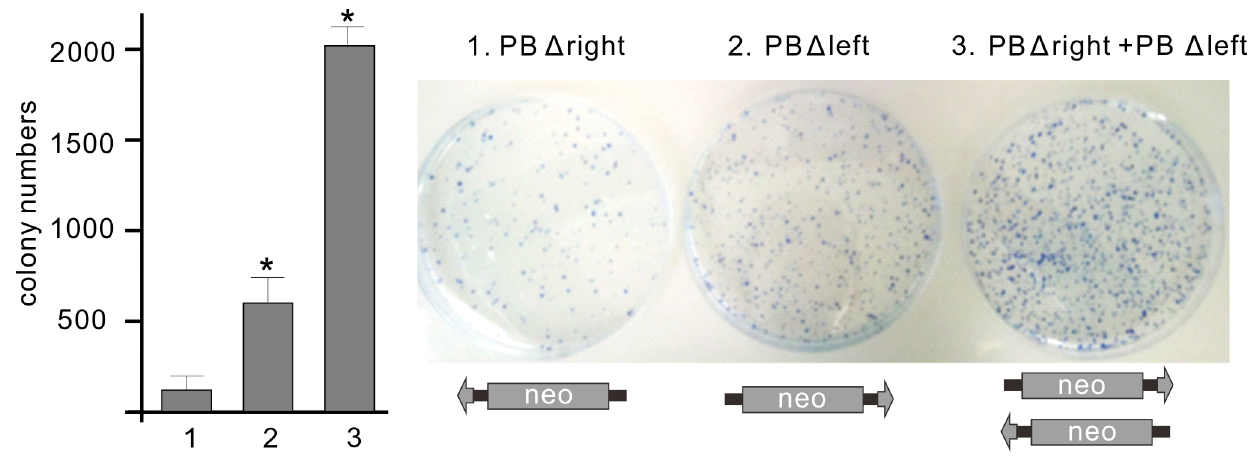
Figure 4. Bimolecular transposition events generated by PB . Transposition assay was performed by using ‘solo’ transposon substrates, either alone or mixed in equimolar ratios, in the present of the mPB transposase. The statistical significance of differences is shown by asterisk above the bars, *P , 0.05. Molecular analysis identified no transposase-mediated integration events in the resistant colonies using PB D right (background). See also Table